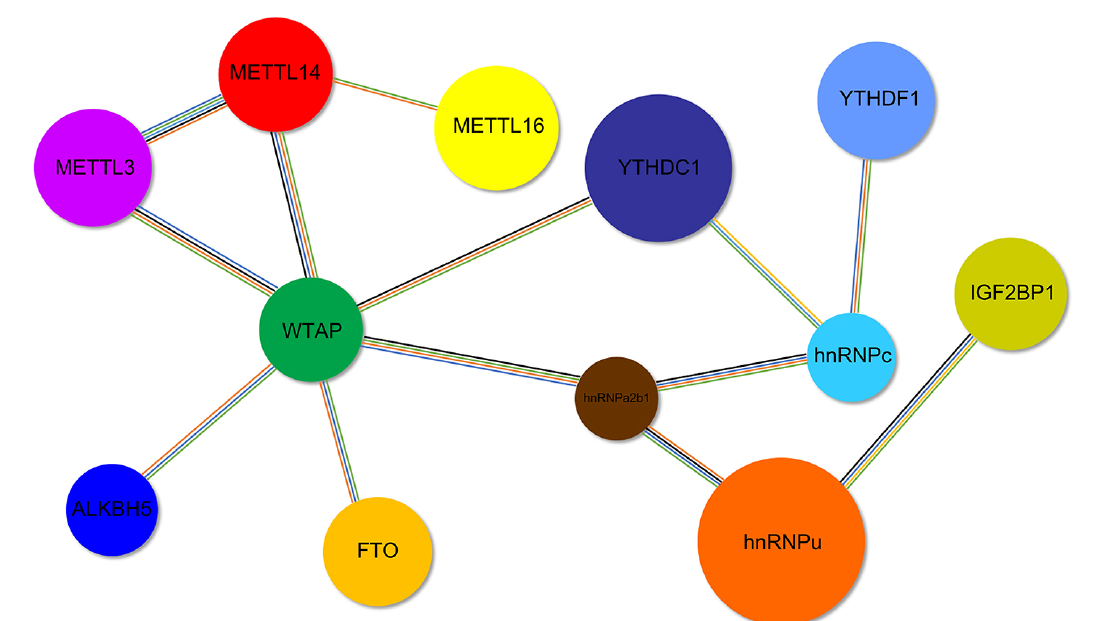
Figure 2 – Network of m6A-related genes. WTAP is a regulatory subunit required for the METTL3/METTL14 heterodimer complex. METTL16 is essential for RNA binding and methylation activity, and is associated with METTL14. FTO and ALKBH5 mediate RNA demethylation at the m6A modification site, causing unmethylated RNA to be bound by HuR protein, leading to constitutive expression. YTHDC1, YTHDF1, and IGF2BP1 recognize the methylation site and regulate mRNA degradation. hnRNPs regulate the expression of YTHDC1, YTHDF1, and IGF2BP1 in m6A